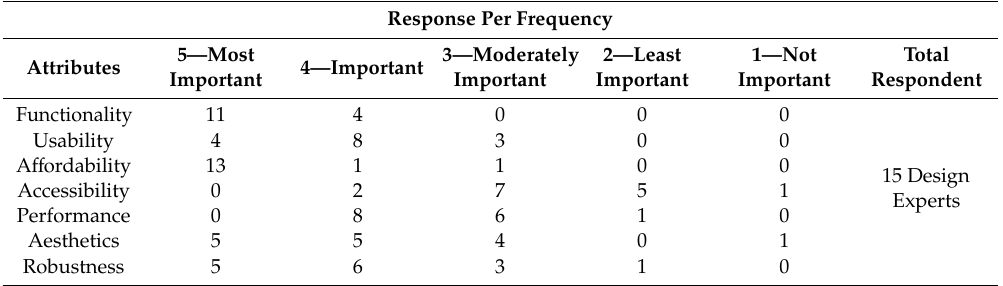
Table 3. Factors a ff ecting designing of a frugal innovation (design expert